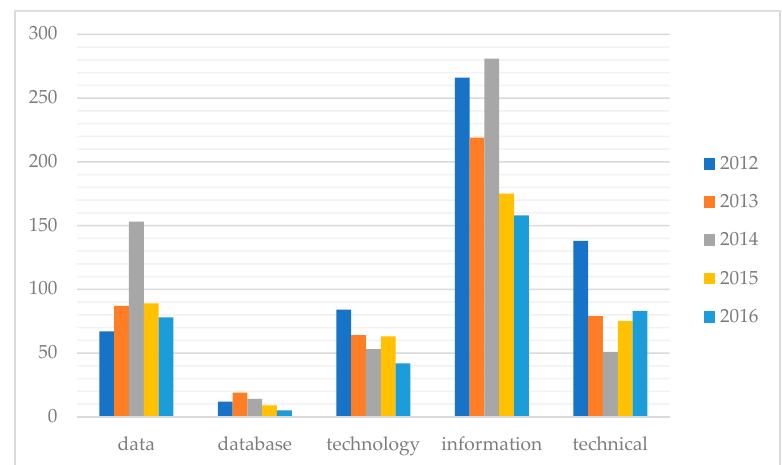
Figure 4. The frequencies of five keywords relevant to AI (x-axis) in Vietnam’s Ministry of Health’s annual reports from 2012–2016 (y-axis: number of appearances). The results were obtained from the text mining of the ministry’s reports in R software (version 3.4.1).